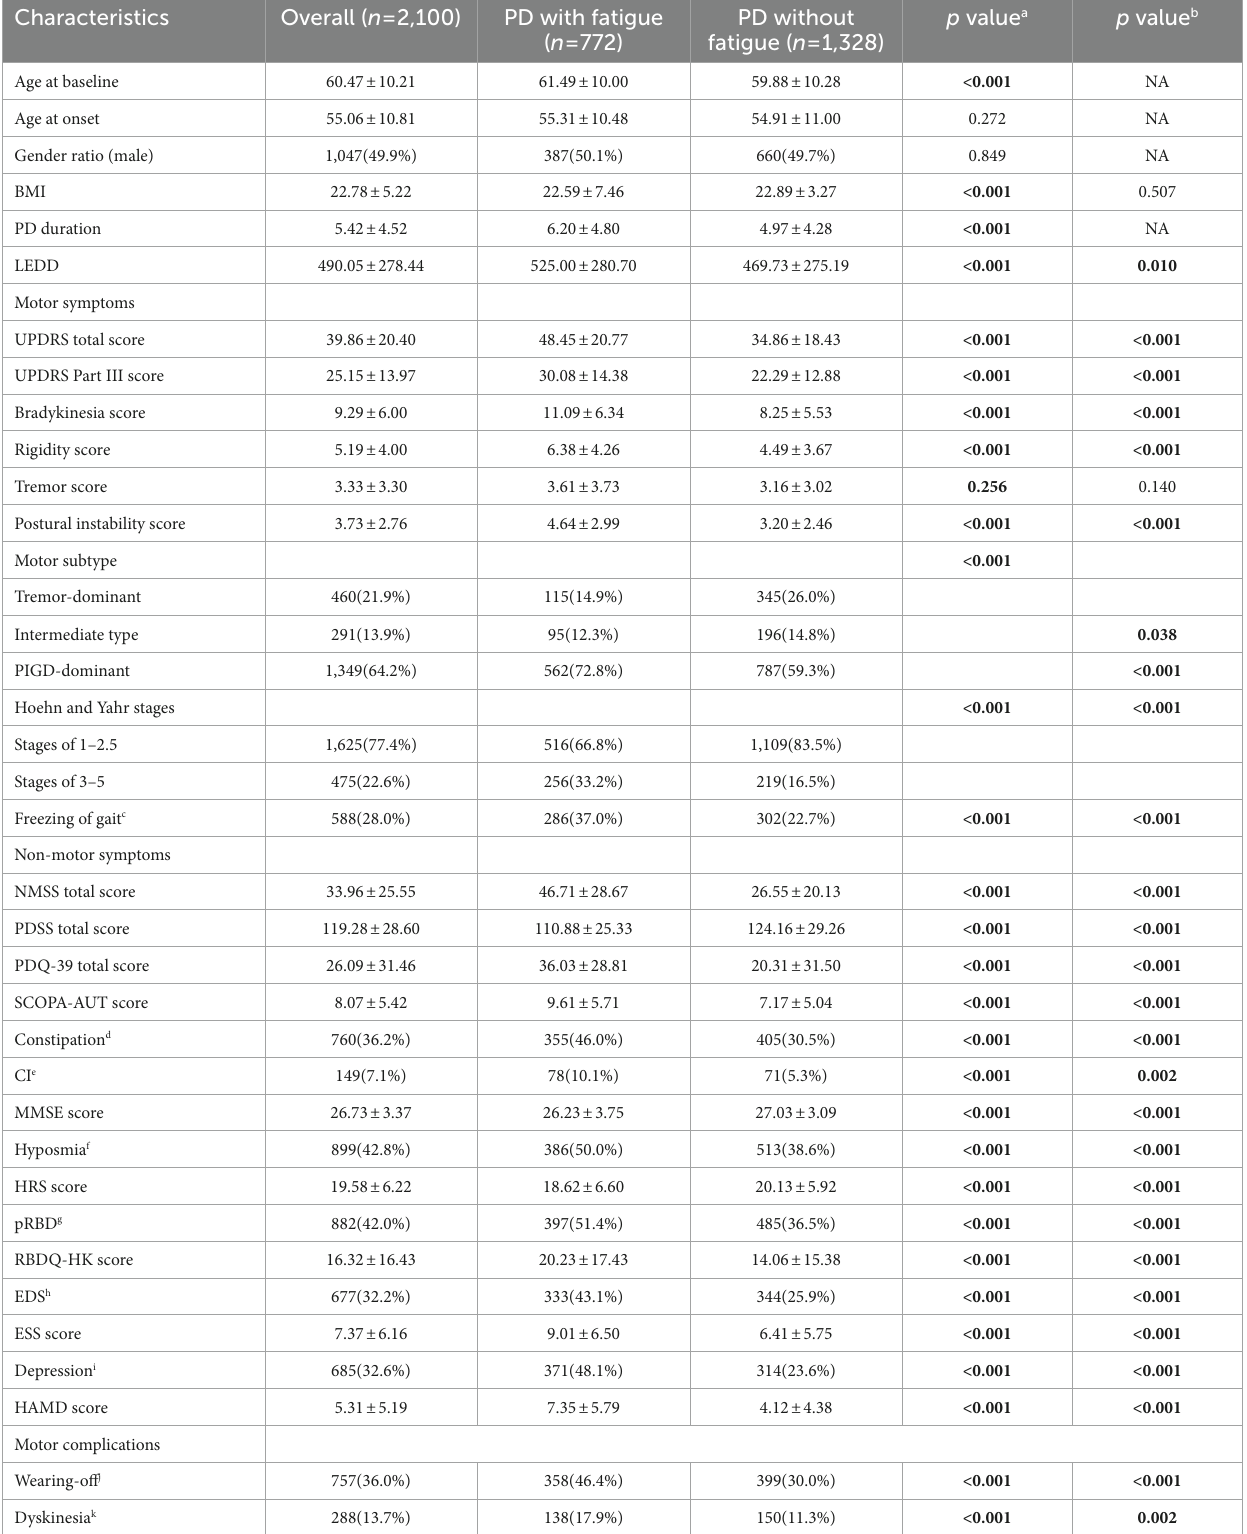
TABLE 1 Demographic and clinical characteristics of patients with PD at baseline.